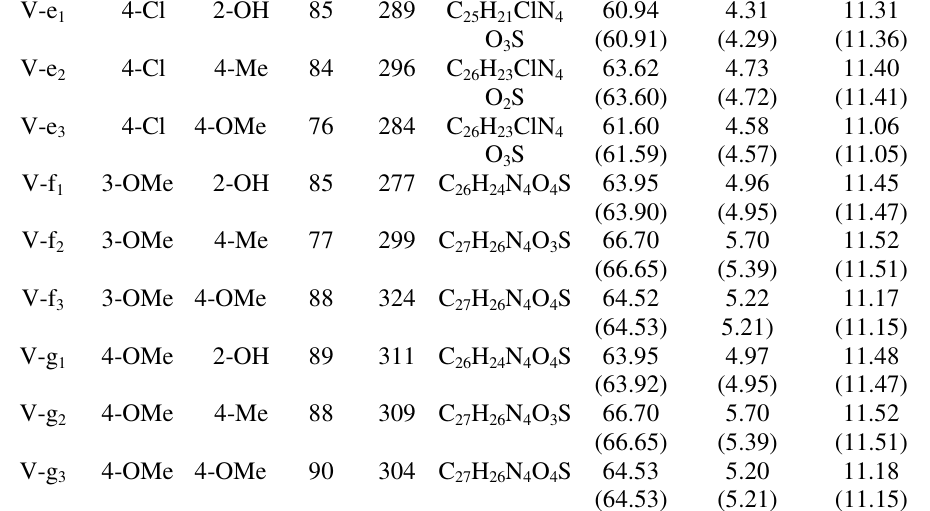
Table 8. Spectral characteristics of compounds from V-(a-g)